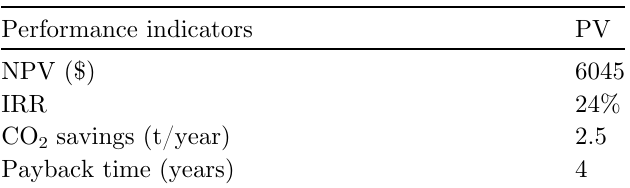
Table 3. Performance indicators for the electricity part (PV panels).